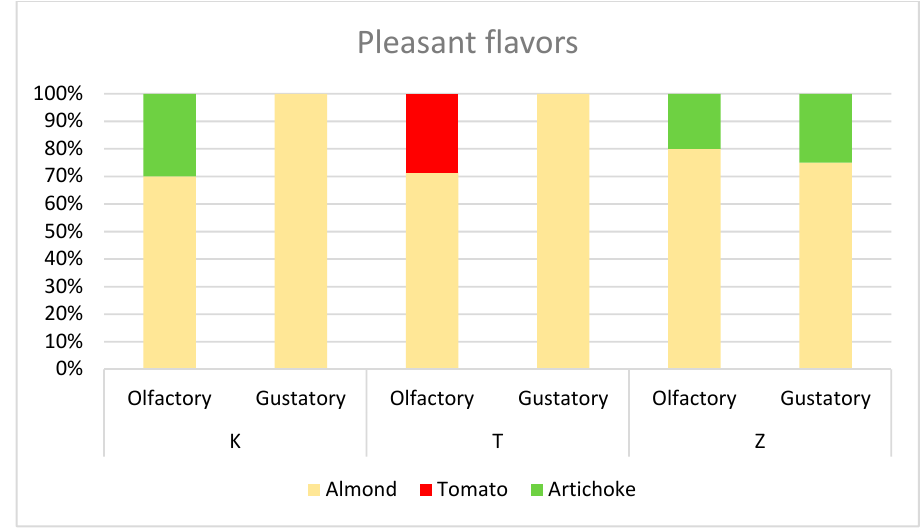
Figure 8. Pleasant flavors of olive oils produced by plants treated with CHA-zeolitite (Z), Kaolin (K) and untreated plants (T).